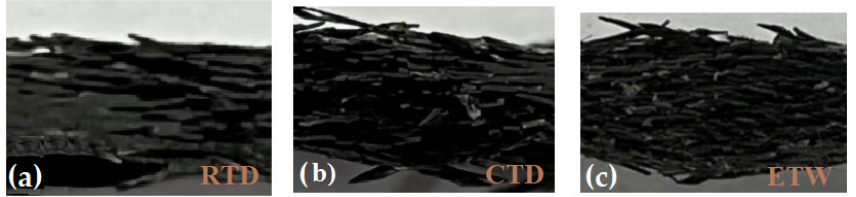
Figure 7. Fatigue failure morphology along the direction of thickness in three environments. ( a ) RTD; ( b ) CTD; ( c ) ETW.